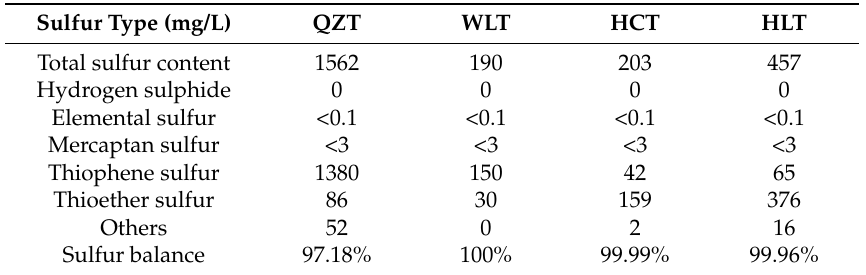
Table 3. Test results of sulfur composition in operating